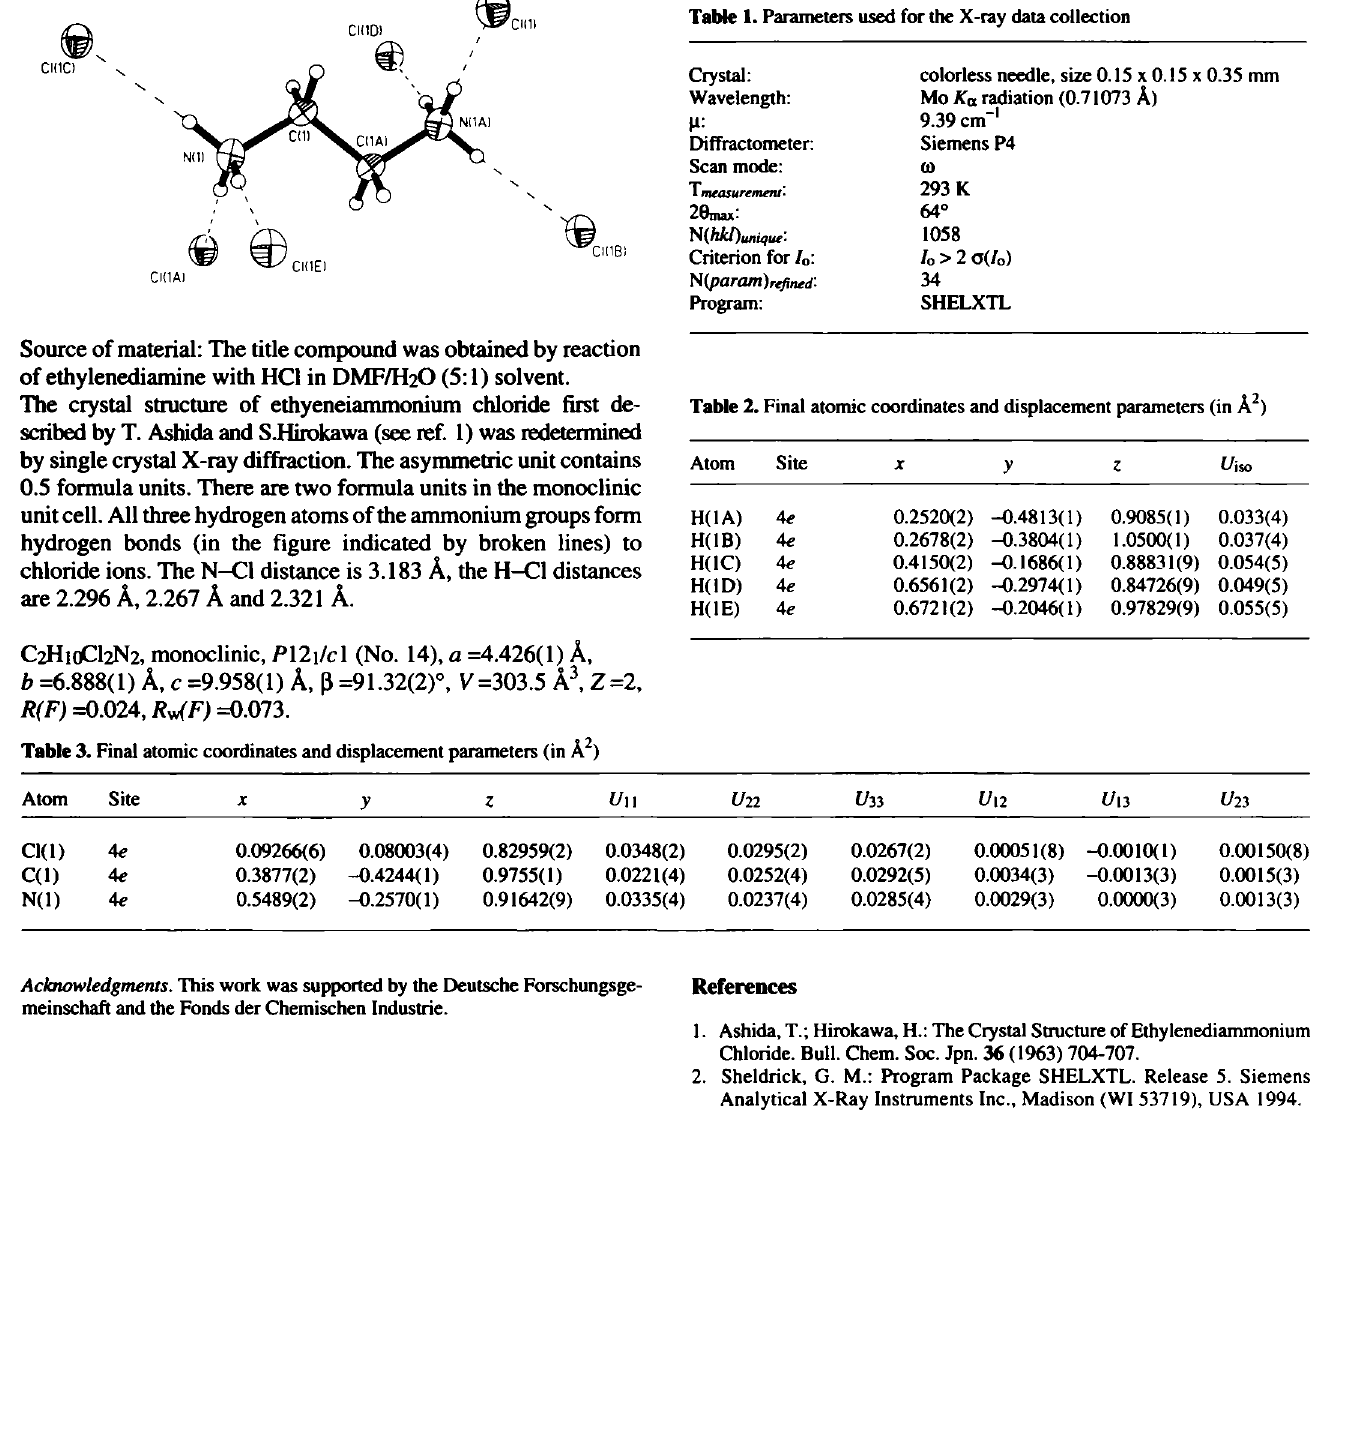
Table 1. Parameters used for the X-ray data collection Crystal: